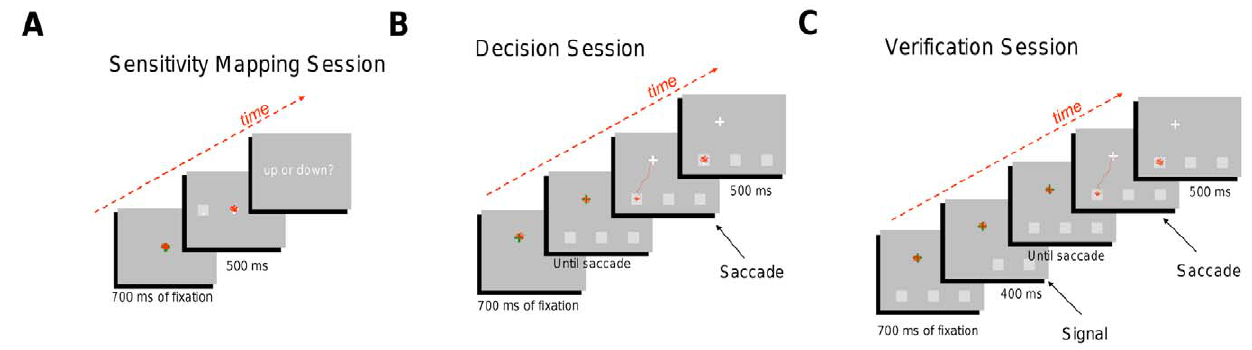
Figure 3. Experiment 1: A. Retinal mapping session. The observer first fixated a fixation cross for 700 msec. Then a target appeared on the right or left of the fixation point. The target was displayed for 500 ms and then disappeared. A response screen was displayed until observers indicated their response. B. Decision session. The observer first fixated a fixation cross for 700 msec. Then square markers appeared at the three locations to which the observer was permitted to saccade. Once the observer completed the saccade, the target configuration appeared at one of the side locations chosen at random. The observer then judged whether the target was dot-up or dot-down. We compared human performance to performance maximizing probability of correct discrimination. C. Verification session. The protocol was the same as the Decision session except for the addition of a 400 ms phase, before the saccade, where one of the 3 tokens disappeared. This token indicated the position that the observer should saccade to. If the observers made his saccade to another location (fixation position not within a 1 u radius of the indicated object) the trial was aborted and replayed later. Actual eye movement data for one trial for one observer is superimposed in red on the stimulus arrays.